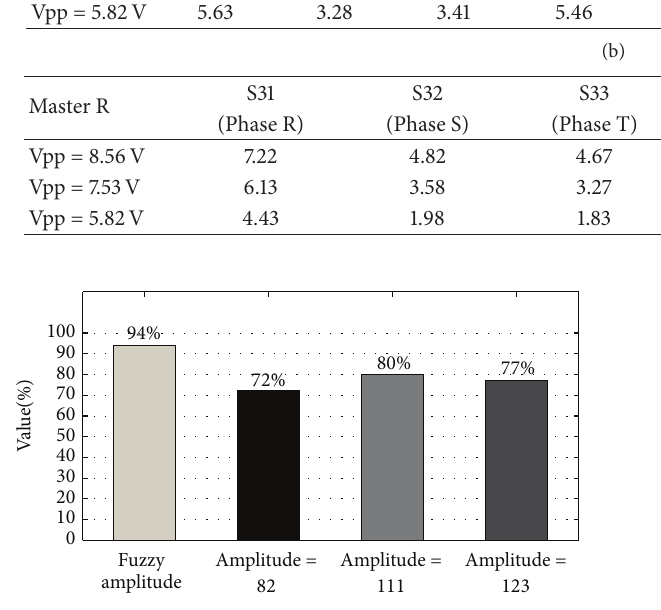
Figure 9: Throughput/Workload percentage comparison with 50 devices.